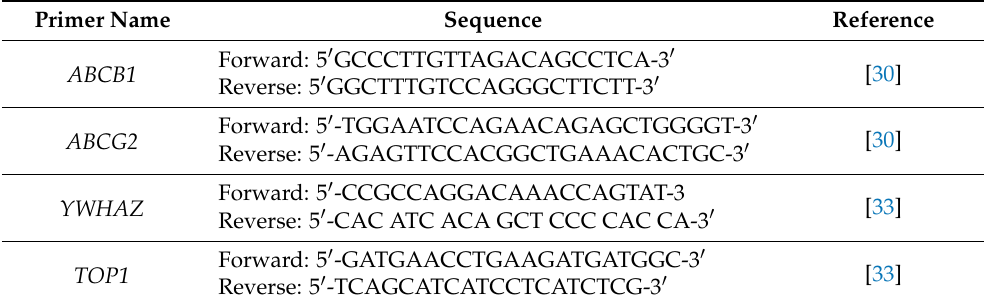
Table 1. List of primers used in this